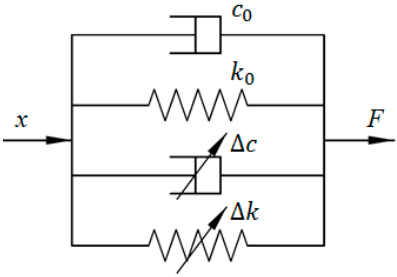
Figure 1. Kelvin–Voigt model.